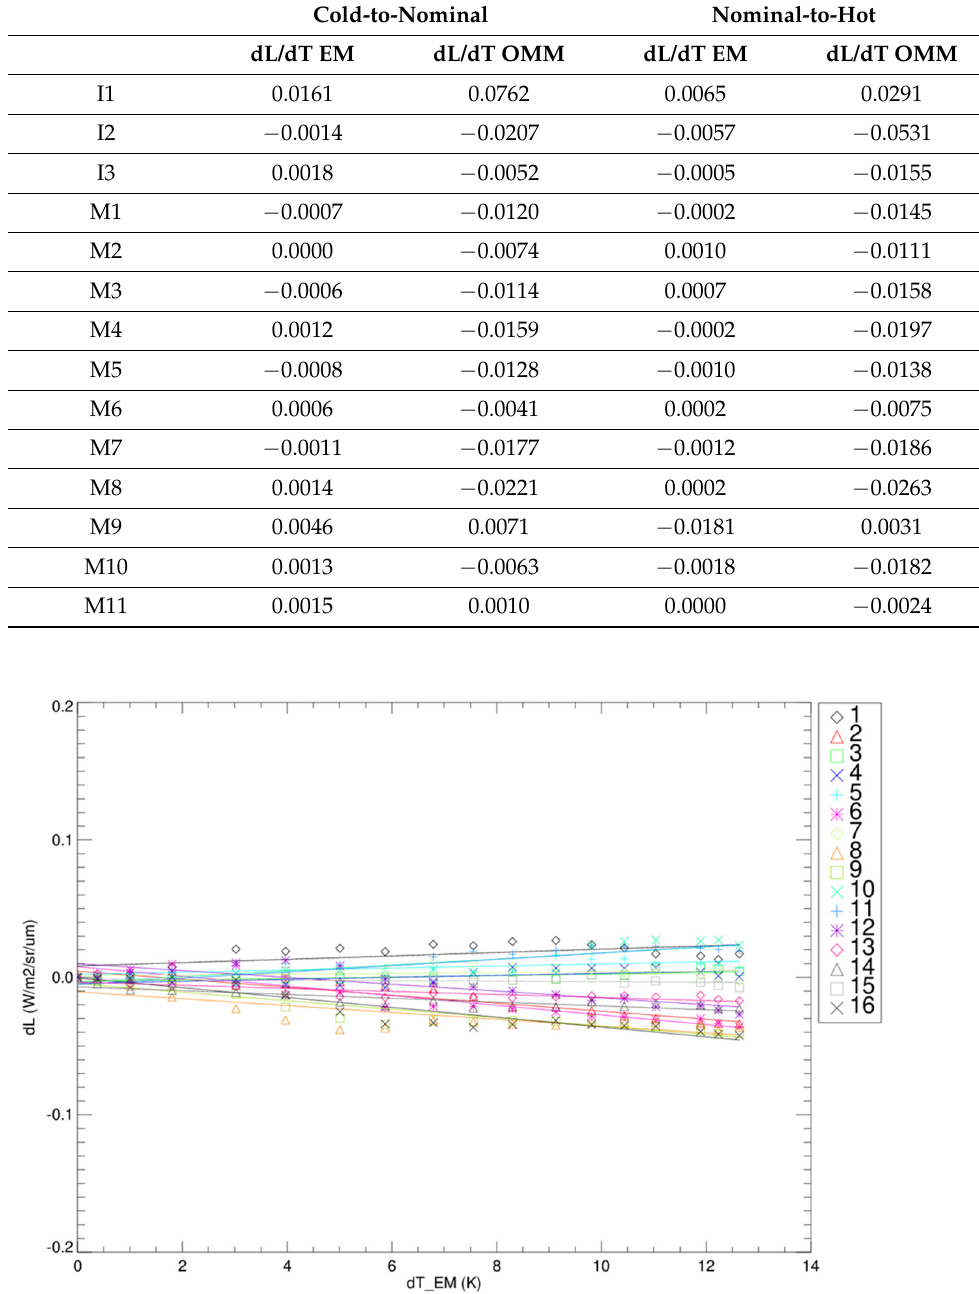
Table 5. VIIRS radiometric sensitivity to temperature change of the instrument. Columns 2 and 3 are for electronics module and optomechanical module temperature sensitivities for the TVAC transition from cold to nominal plateaus and columns 4 and 5 are the corresponding sensitivities for the nominal-to-hot plateau transition.